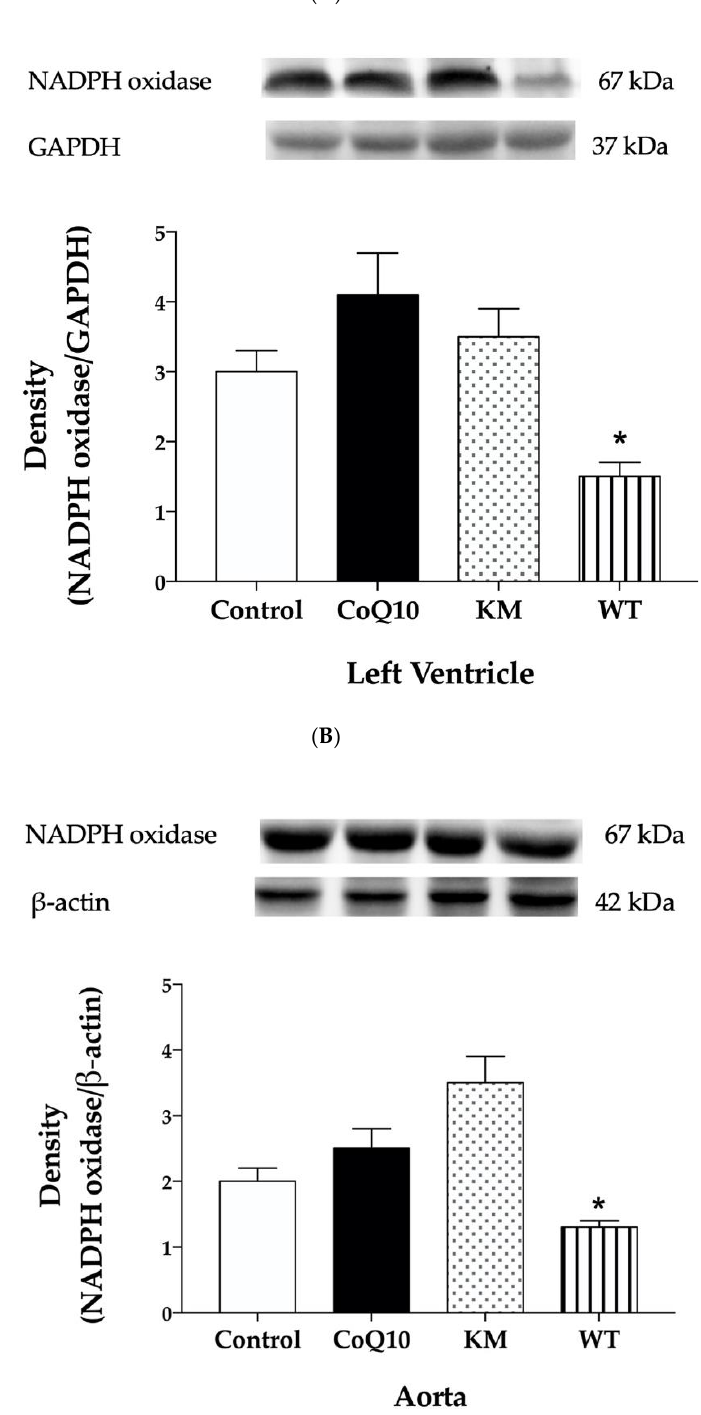
Figure 4. E ff ect of CoQ10, KM, and WT on NADPH oxidase protein expression in the left ventricle (LV) ( A ) and aorta ( B ). CoQ10—coenzyme Q10, KM—Koralovij Marka, WT—Wild Type. Data are means ± SEM from 6 animals in each group. * p < 0.05 compared to the control group.